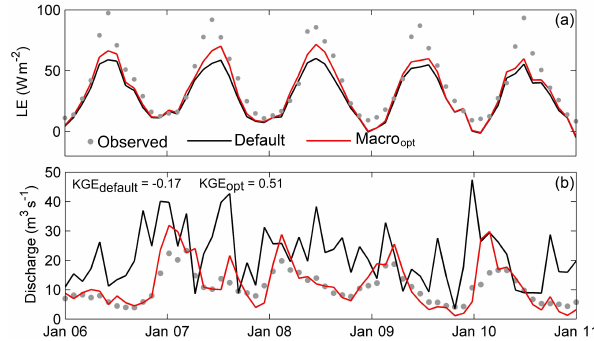
Figure 8. (a) Spatially averaged monthly latent heat flux (LE) from MODIS, default and macro opt configurations over the Ken- net catchment and (b) monthly average observed and simulated dis- charge from the default and macro opt configurations at the Kennet at Theale gauging station.